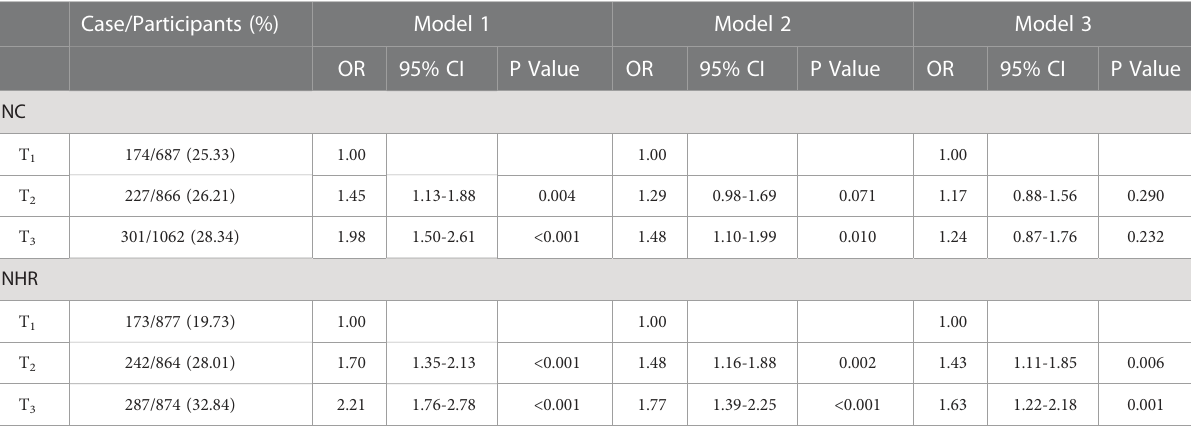
TABLE 2 Associations of NC and NHR with the prevalence of DKD in patients with